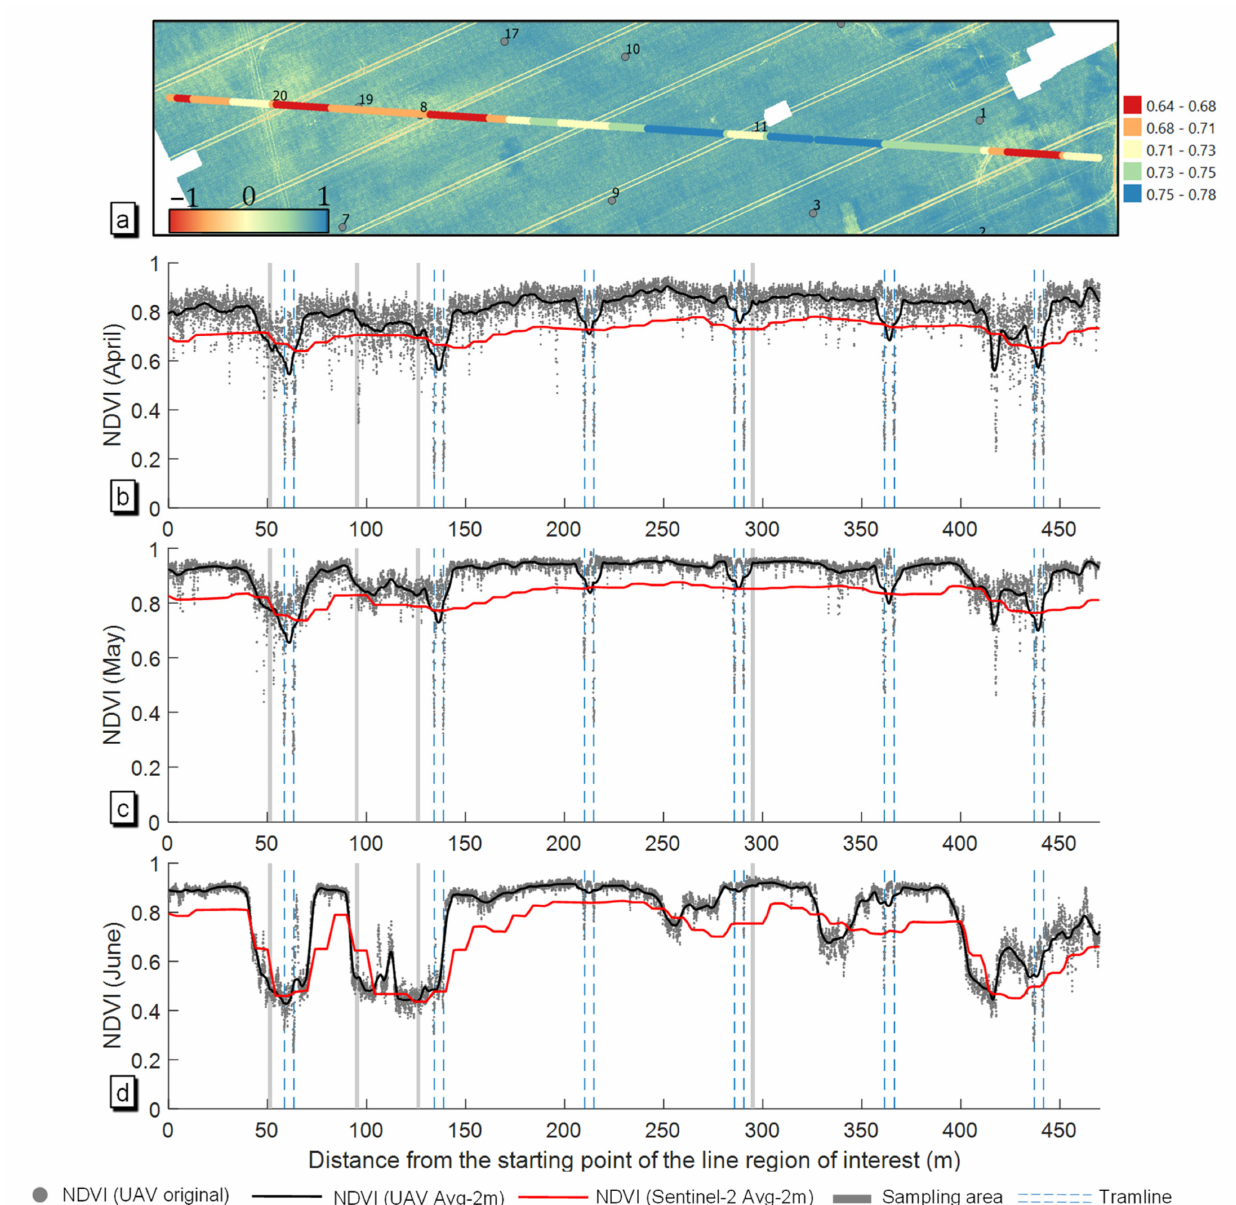
Figure 11. Comparison of NDVI values between UAV imagery and Sentinel-2 data based on moving averages (2 m buffer size) extracted along a 470 m transect line within field A. ( a ) Transect line showing the Sentinel-2 averages superimposing the UAV image from April. In the diagrams ( b – d ), the moving average values from the UAV (black lines) and the Sentinel-2 image (red lines) are superimposing the NDVI values from UAV imagery in original resolution (grey dots) from April, May to